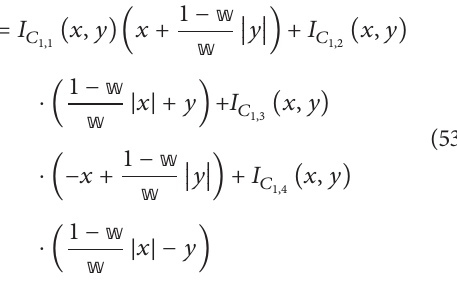
Figure 1. If w ∈ (0, 1)